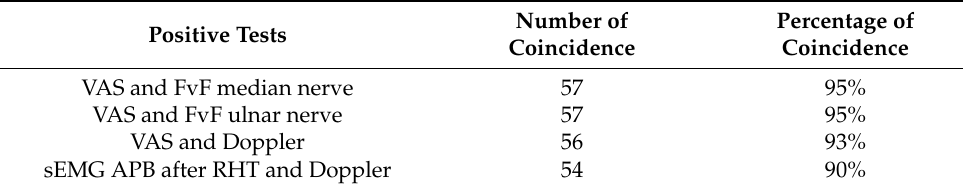
Table 2. The overlapping of the positive tests results recorded on the symptomatic side in clinical and neurophysiological examinations of the 60 studied TOS patients. Number of Percentage of Positive Tests Coincidence Coincidence VAS and FvF median nerve 57 95% VAS and FvF ulnar nerve 57 95% VAS and Doppler 56 93% sEMG APB after RHT and Doppler 54